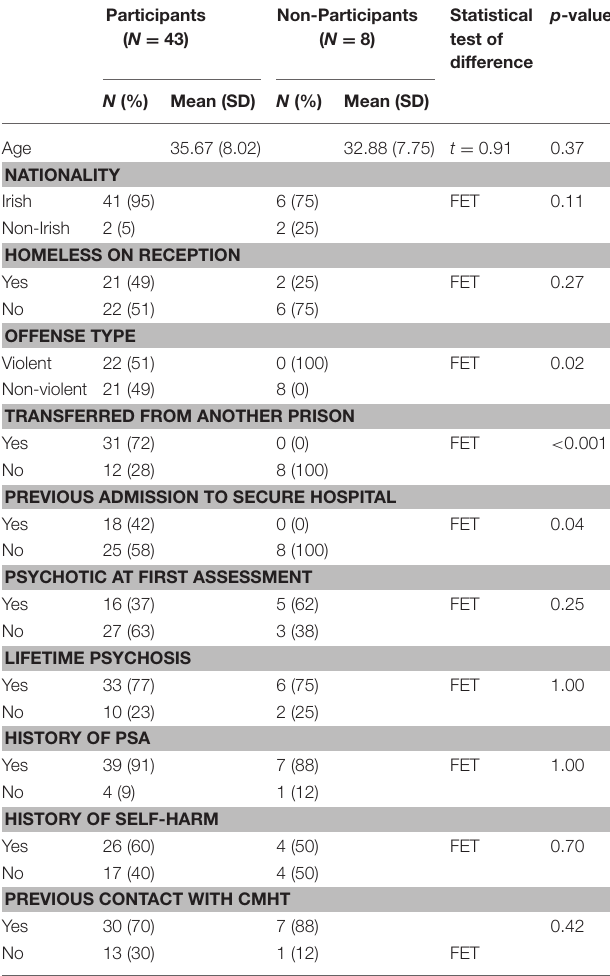
TABLE 1 | Comparison of demographic, legal and clinical characteristics of participants and non-participants of the PReP